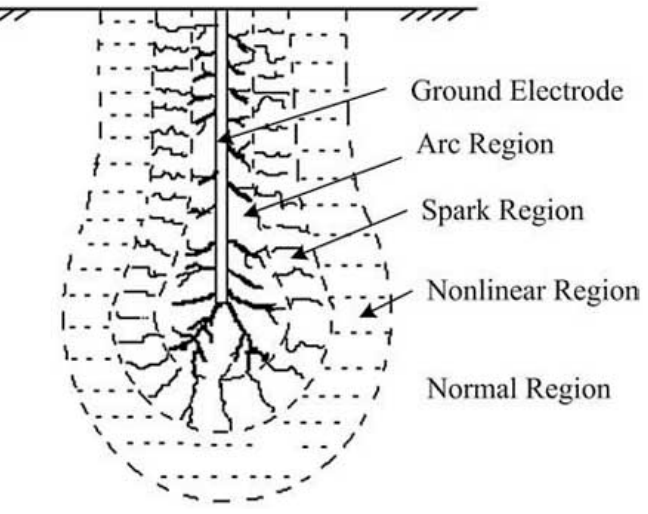
Figure 1. Breakdown region in soil near an earthing electrode [11].